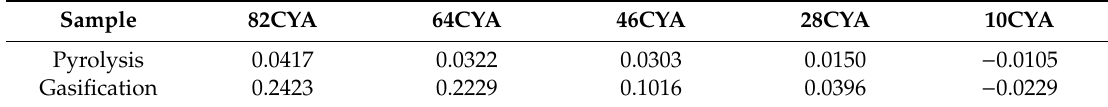
Table 2. The interaction index MR of the pyrolysis and gasification